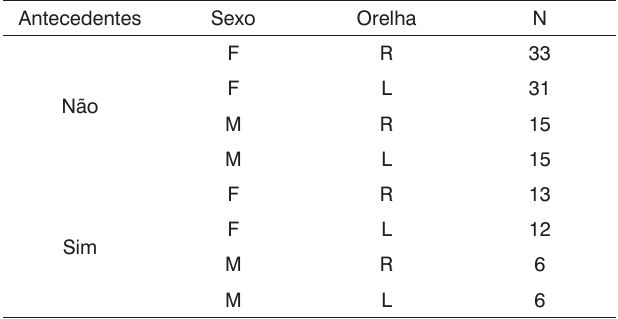
é referente à intensidade do estímulo da frequência f tal forma que os dois estímulos sejam apresentados com intensidades desiguais. A pesquisa das curvas de